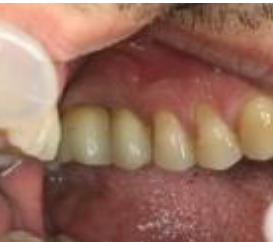
Figure 12. Final rehabilitation. It was preferred to finalize the case with a premolar 1.6.